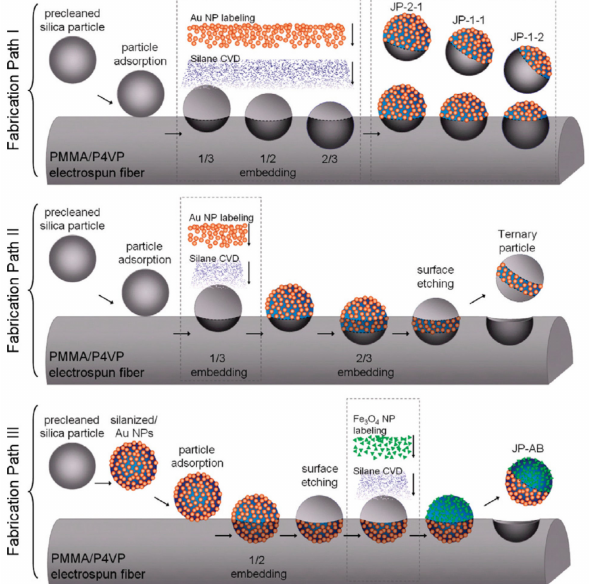
Figure 5. Three fabrication paths for (I) three kinds of asymmetric Janus particles, (II) ternary particles, and (III) biofunctionalized Janus particles. Reprinted with permission from ref. [100]. Copyright © 2010 American Chemical